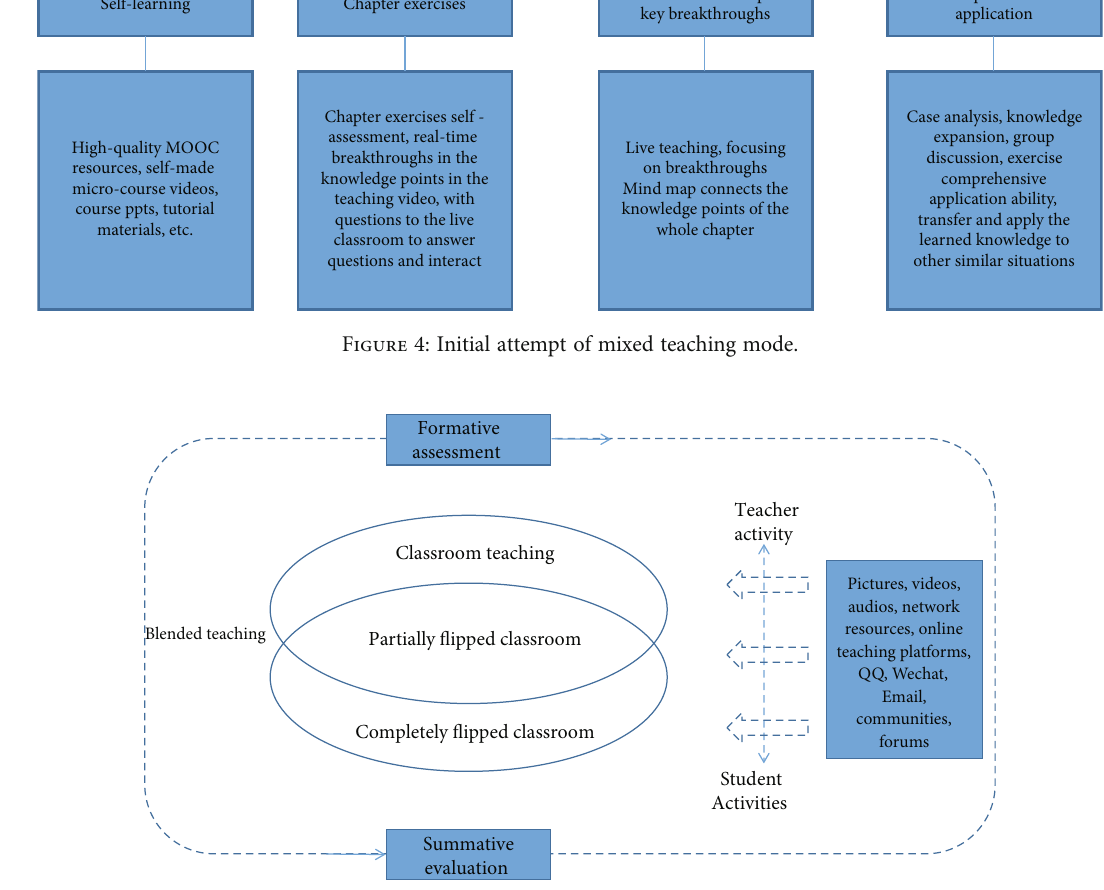
Figure 5: Frame structure of modern mixed teaching